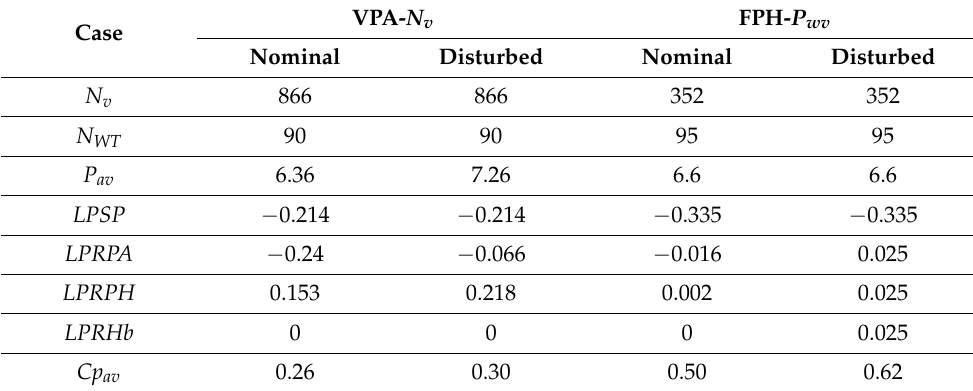
Table 4. Comparing operation under